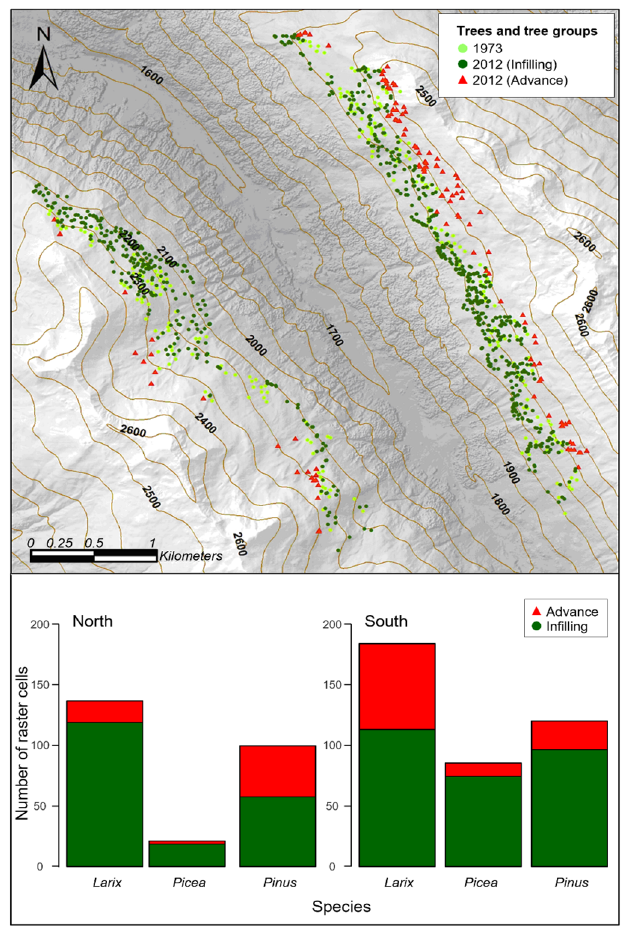
Figure 1. Upper panel: forest change in the study region derived from terrestrial mapping of trees and tree groups at treeline. A moving window analysis was used to discriminate between treeline advance and infilling below treeline. Light green circles represent trees or tree groups that were already present in the treeline ecotone in the 1972 survey. Red triangles represent individual trees and tree groups classified as advance, and dark green circles are trees and tree groups classified as infilling. Classification was calculated at a 50 m pixel resolution using a neighborhood elevation analysis comparing position of trees and tree groups in 2012 (dark green and red symbols) to 1972 (light green circles). Lower panel: classification of the trees and tree groups that established in the time interval between the two surveys (1972–2012). Bars represent the number of raster cells with trees classified as advance or infilling on the two valley slopes separated by